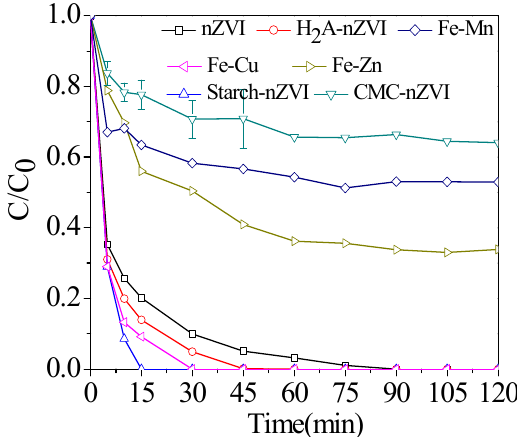
Figure 10. The concentration of Cr(VI) as a function of time with supported nZVI. ([Cr(VI)] = 25 mg/L, adsorbent = 0.5 g/L, pH = 3, T = 293 K).